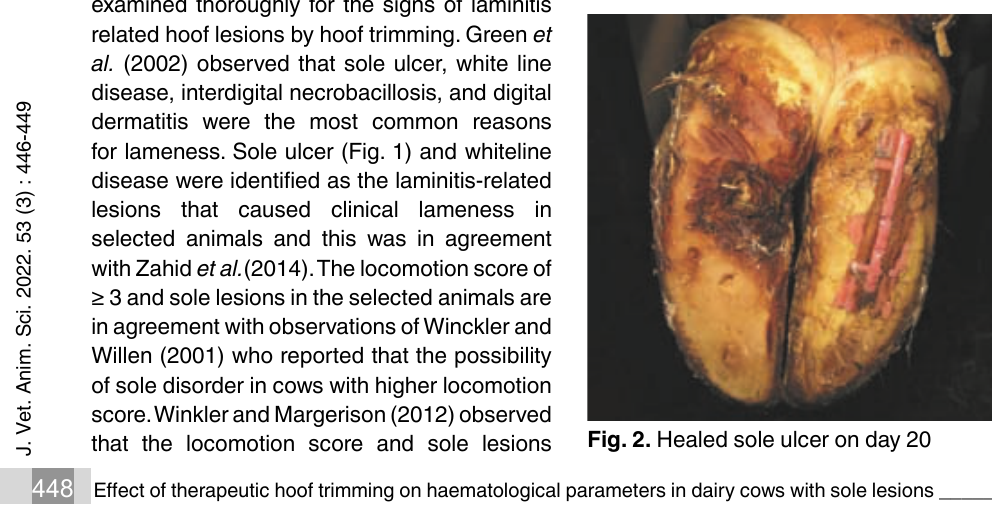
Fig. 1. Sole ulcer on the first day of treatment